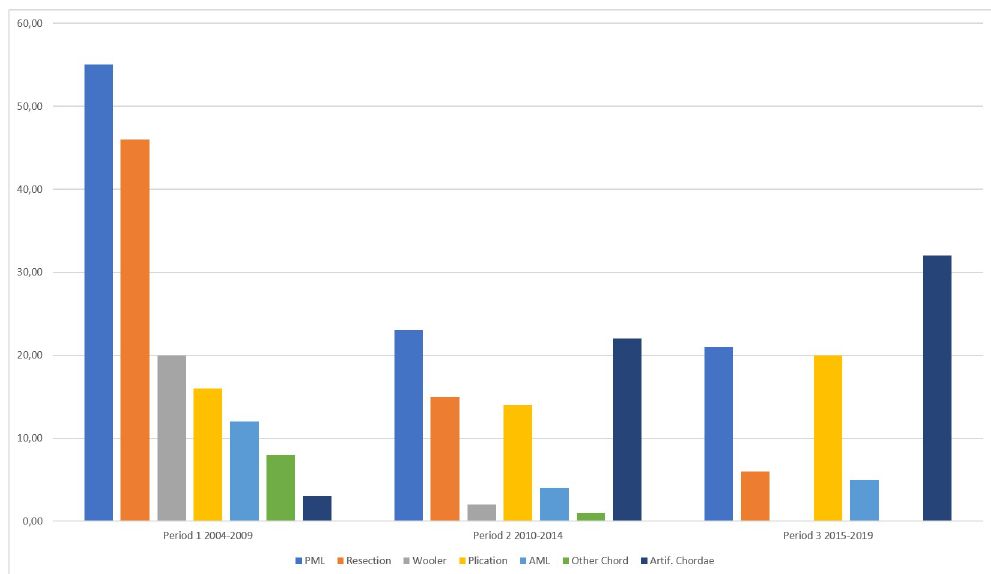
Fig 1. Shift of additional reconstruction measures. PML = Corrective measure on the posterior mitral leaflet; Resection = All types of resection measure on either leaflet; Wooler = Commissural reduction plasty according to Wooler; Plication = Plication on the leaflets without resection; AML = Corrective measure on the anterior mitral leaflet; Other Chord = Repositioning, shortening of the native chords, shortening of the origin of the chord by means of splitting or trimming or repositioning of the papillary muscle; Artif. Chordae = Chordae replacement with artificial chords.